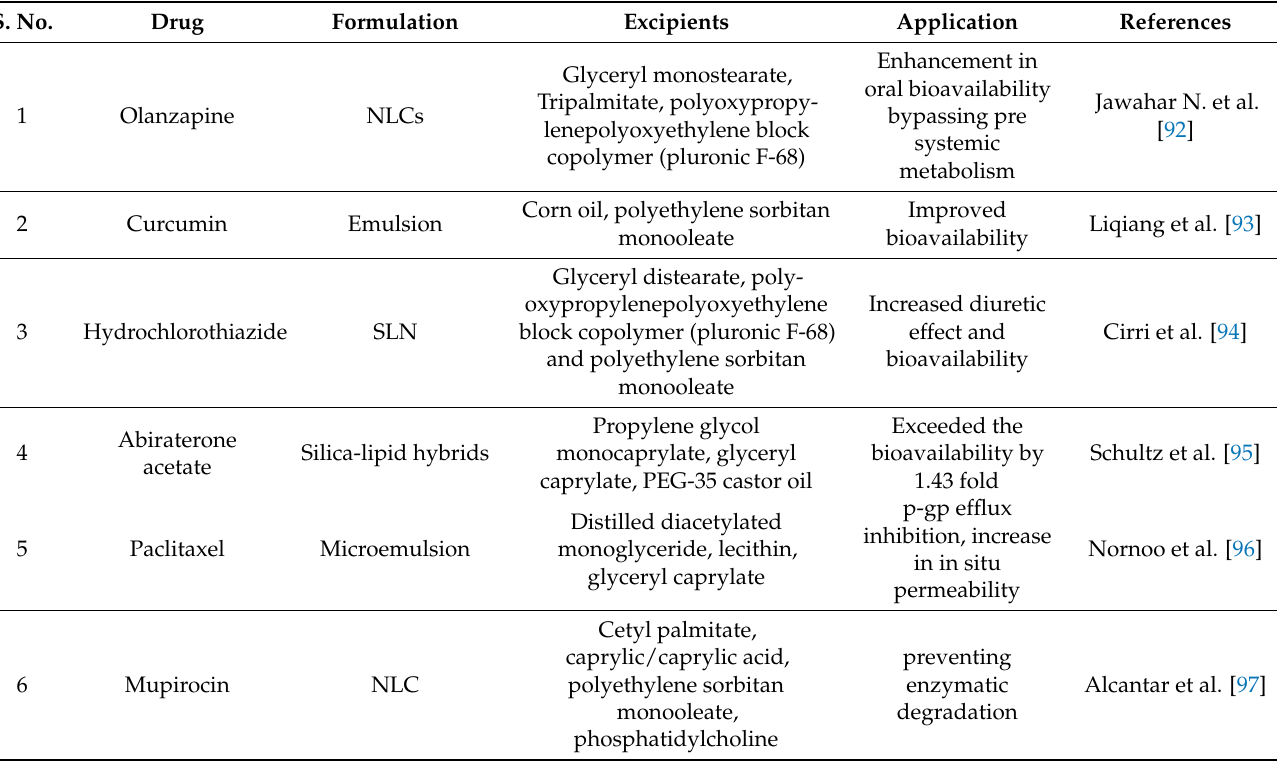
Table 2. Summary of application of lipid